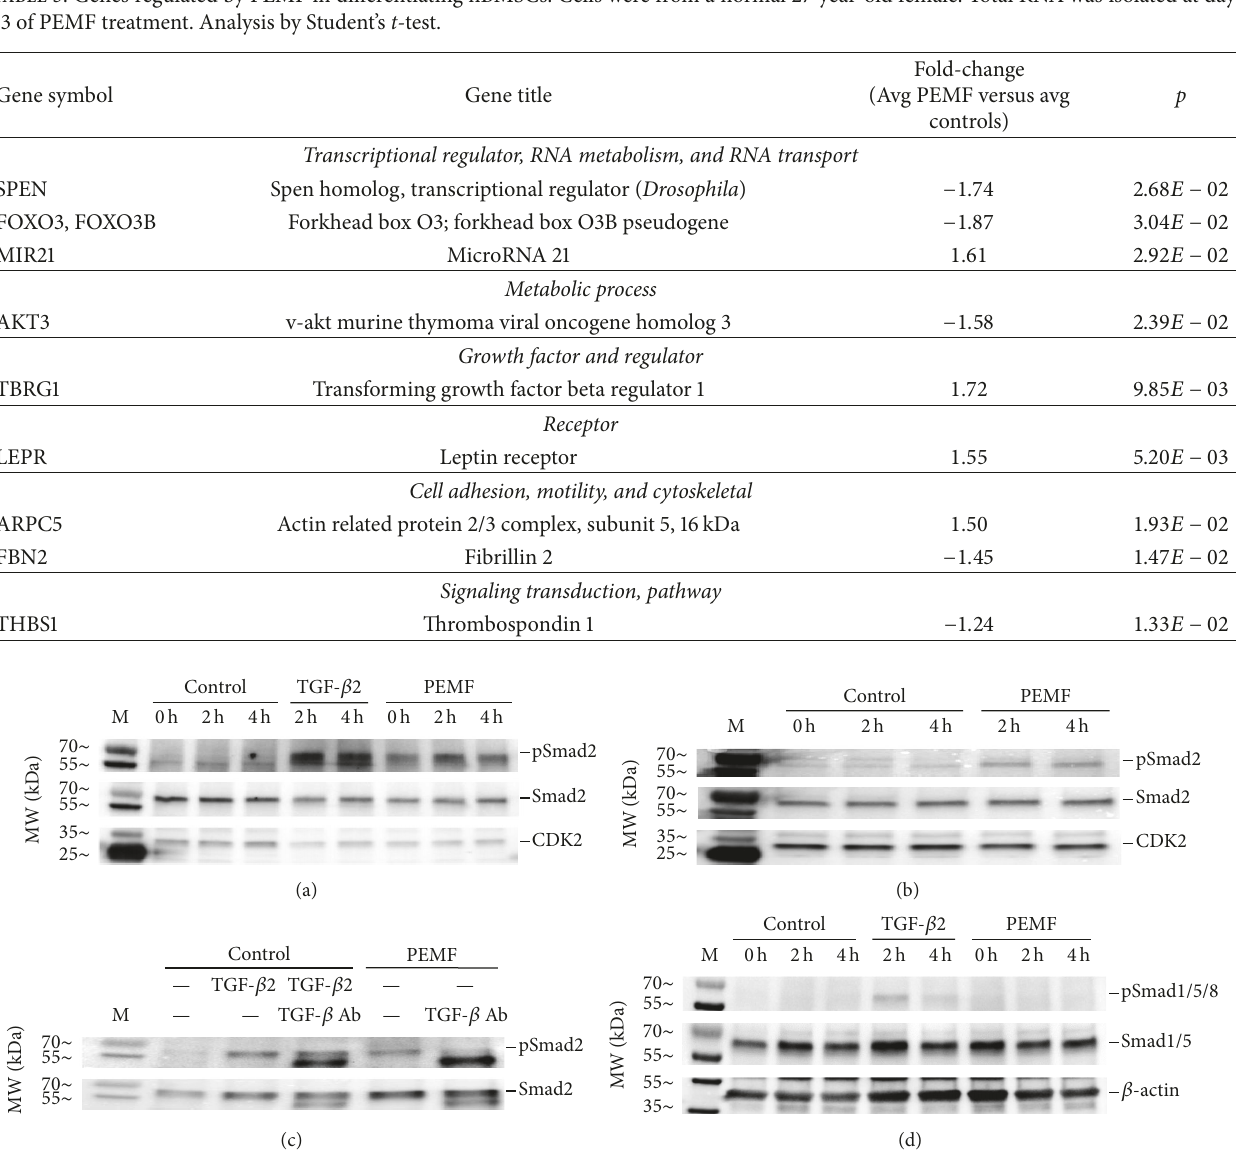
Figure 4: PEMF resulted in activation of the TGF- 𝛽 signaling pathway in human osteoblastic cells during differentiation and mineralization. (a) Whole cell lysates after PEMF treatment of hBMSCs of a 24-year-old female at day 23 (differentiation) and (b) at day 33 (mineralization) were subjected to Western blot analysis using the antibodies as indicated for Smad2 and Cdk2. TGF- 𝛽 2 (5ng/mL) was added to control (non-PEMF-treated) cells on days 23 and 33 as positive controls. (c) The pan-TGF- 𝛽 neutralizing antibody (30 ug/mL) was added to the osteogenic medium of hBMSCs from a 24-year-old female during the entire differentiation period and lysates were prepared on day 23 of PEMF treatment, 2 h after PEMF was started or TGF- 𝛽 2 was added and subjected to Western blot analysis. TGF- 𝛽 2 (5ng/mL) was added to control (non-PEMF-treated) cells on day 23 as a positive control. Cdk2 was used as loading control. (d) The same lysates were subjected to Western blot analysis for phosphorylation of Smad1/5/8 as